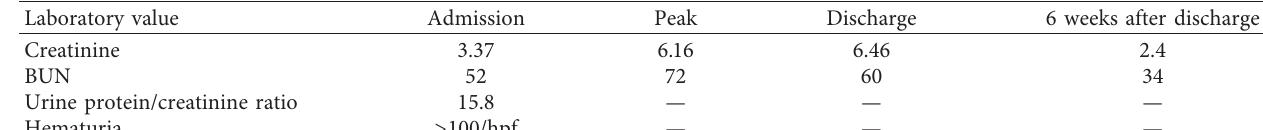
Table 2: Renal parameters from admission to 6-week follow-up.